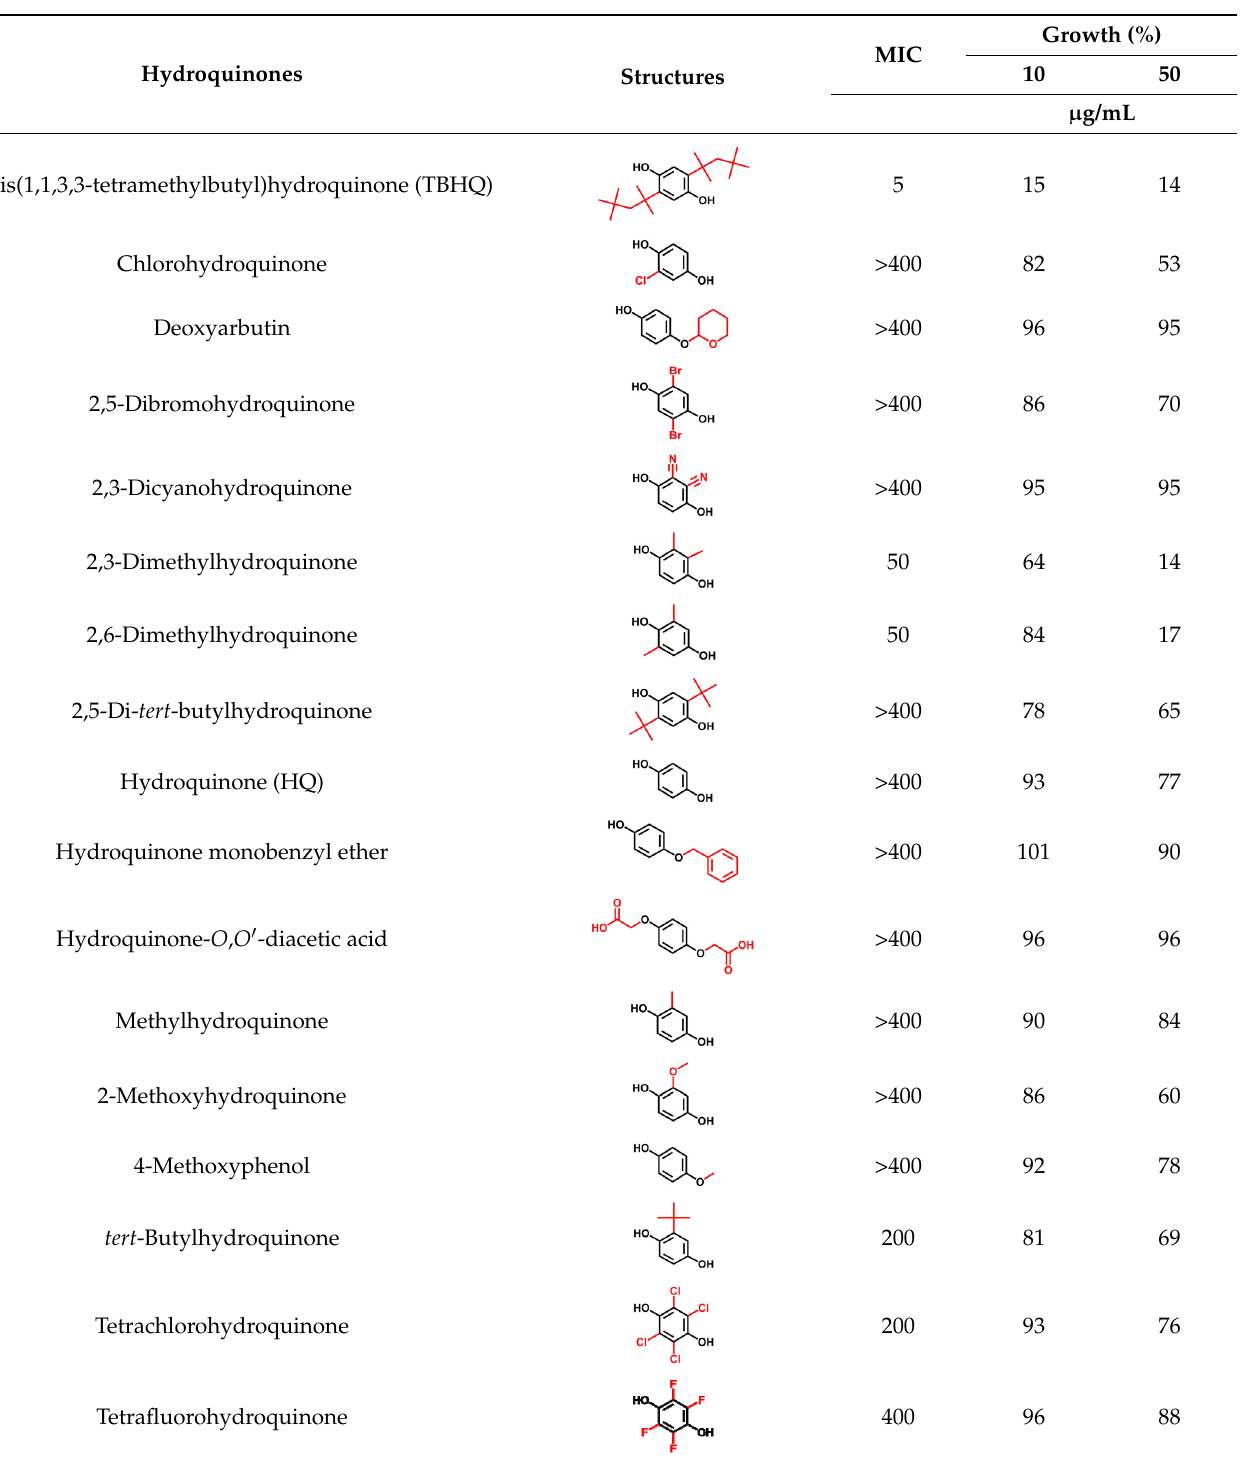
A more detailed biofilm study showed that TBHQ at lower doses (0.2, 0.5, 1, 2, or 5 µg/mL) dose-dependently inhibited biofilm formation by the two methicillin-sensitive S. aureus strains (MSSA 6538 and MSSA 25923) and two methicillin-resistant S. aureus strains (MRSA MW2 and MRSA 33591) (Figure 1B–E). For example, at 1 or 2 µg/mL, TBHQ in- hibited S. aureus biofilm formation by all four strains by ~93% and ~95%, respectively, with MICs of ~5 µg/mL. Interestingly, at the subinhibitory concentration of 0.2 µg/mL, TBHQ increased biofilm formation by 48% and 30% against MSSA 6538 and MRSA 33591, respectively, as compared with non-treated controls. This phenomenon is in line with a previous report that subinhibitory concentrations of aminoglycoside antibiotics induced biofilm formation by Pseudomonas aeruginosa and Escherichia coli [7]. Furthermore, plank- tonic cell growth curves confirmed that the MIC of TBHQ was 5 µg/mL and that at 1 to 2 µg/mL TBHQ delayed planktonic cell growth, whereas HQ had no effect (Figure S1). These results indicate that the antimicrobial activity of TBHQ partially contributed to its inhibition of S. aureus biofilm formation. 2.2. Microscopic Observations of S. aureus Biofilm Inhibition by TBHQ Bright-field microscopy, CLSM, and SEM were used to observe biofilm inhibition by TBHQ. For non-treated biofilms, 3D color mesh plots were green, indicating abundant biofilm formation, whereas TBHQ at 0.5–2 µg/mL produced yellow to red plots, indicat- ing poor or no biofilm formation. Treatment with HQ had no effect on color plots (Figure 2A). CLSM also showed that TBHQ dose-dependently inhibited biofilm formation vs. un- treated controls (Figure 2B). Biofilm reduction was further quantified using COMSTAT biofilm software, which showed that TBHQ at 1 or 2 µg/mL dramatically reduced average biofilm thickness and substratum coverage and increased biofilm roughness (Figure 2C). Specific biomass, mean thickness, and substratum coverage were reduced by TBHQ at 1 µg/mL by 88%, 89%, and 72%, respectively, vs. non-treated controls. SEM analysis (Figure 2D) also showed that TBHQ markedly reduced the numbers of S. aureus cells, but only slightly affected S. aureus cell morphology on nylon membranes at concentrations of 2 µg/mL. These microscopic findings confirmed that TBHQ at subinhibitory concentrations dose-dependently inhibited S. aureus biofilm